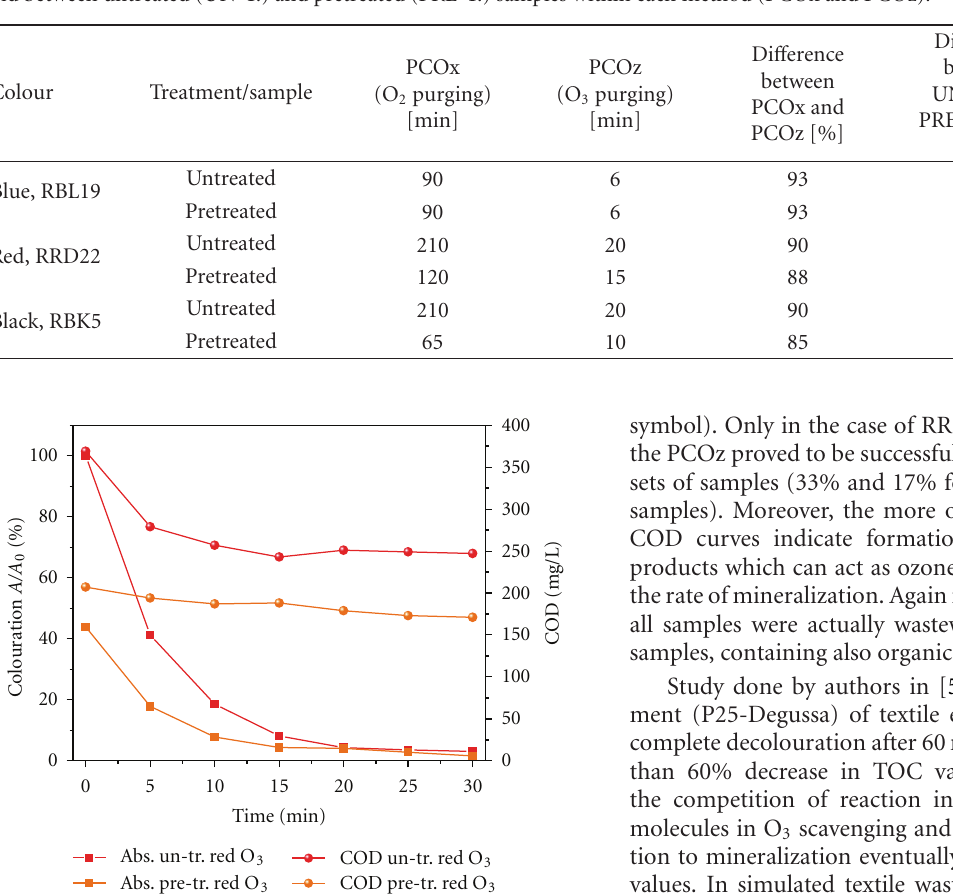
Table 2: Irradiation times given in minutes needed to obtain decolouration of di ff erent samples and the di ff erence between both methods and between untreated (UN-T.) and pretreated (PRE-T.) samples within each method (PCOx and PCOz).